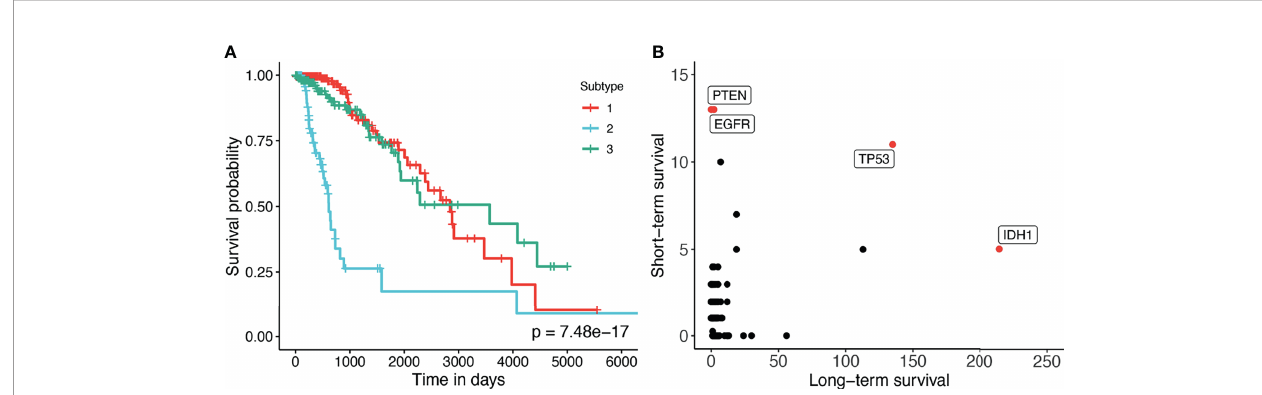
FIGURE 4 | (A) Kaplan – Meier survival analysis of the GBMLGG dataset. The horizontal axis represents the time (days) while the vertical axis represents the estimated survival probability. (B) Number of patients in each group for each mutated gene in GBMLGG dataset. The horizontal axis shows the count for other subtypes with high survival rates, and the vertical axis represents the count in the subtype with low survival rates.